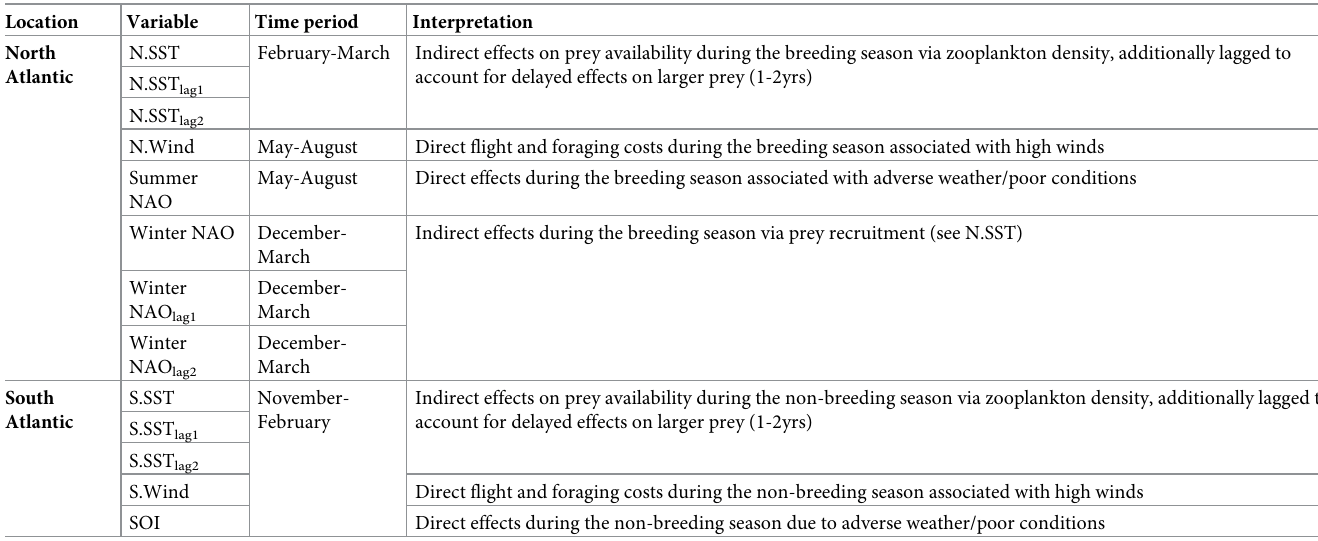
Table 1. Climatic variables considered for association with Manx shearwater